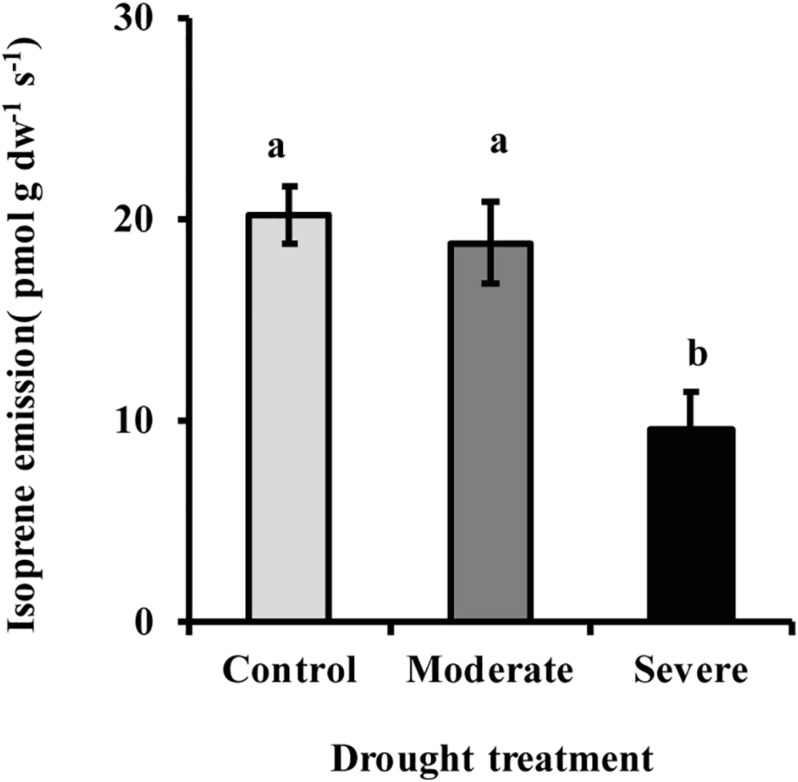
Drought reduced isoprene emission from needles as measured with a PTR-MS. Data shown are means of five biological replicate ± SE. Different letters indicate significant differences at P < 0.05.